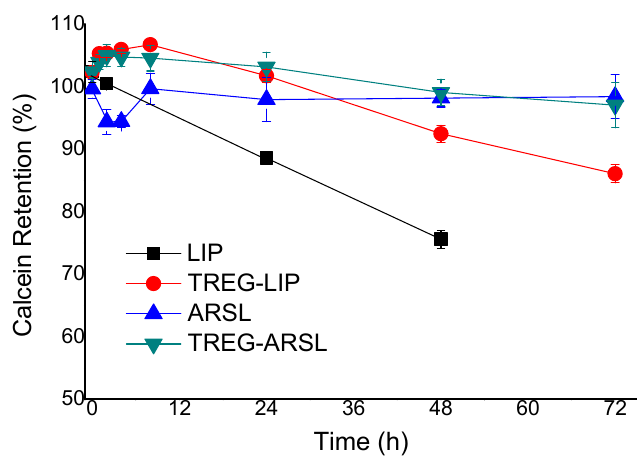
Figure 4. Calcein Retention (%) of vesicles during incubation in FCS at 37 °C.